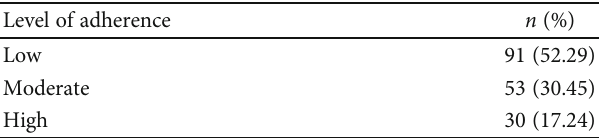
Table 5: Level of medication adherence ( n = 174 ). Level of